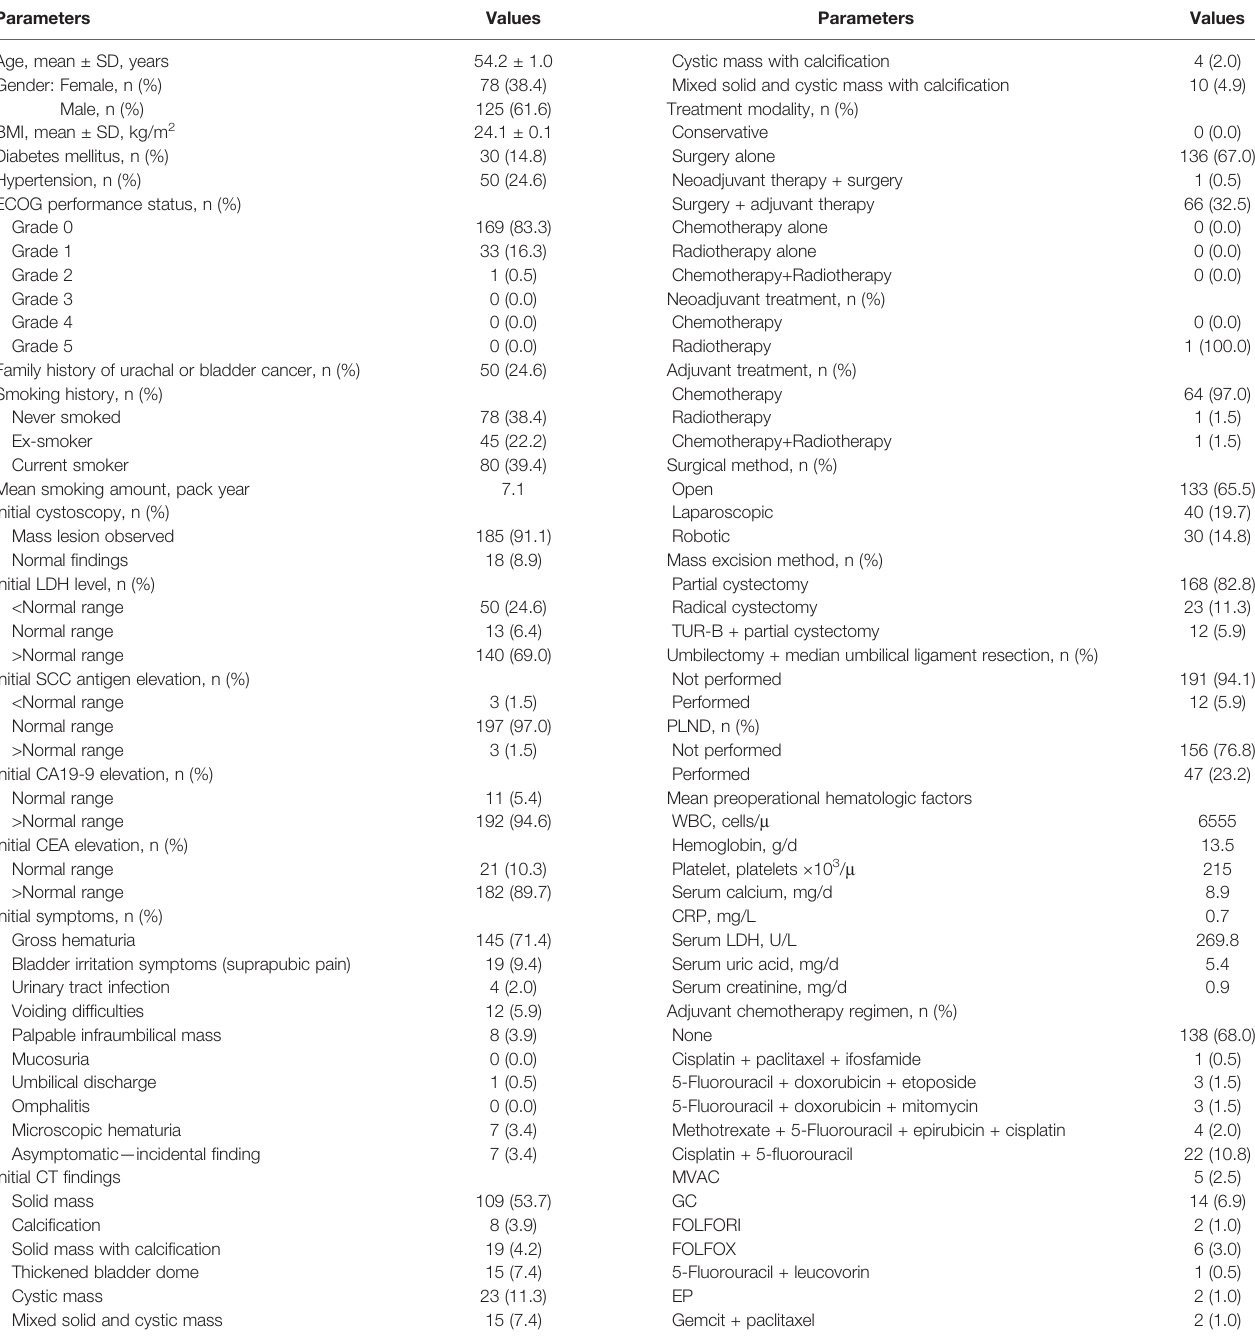
TABLE 1 | Baseline characteristics, n =